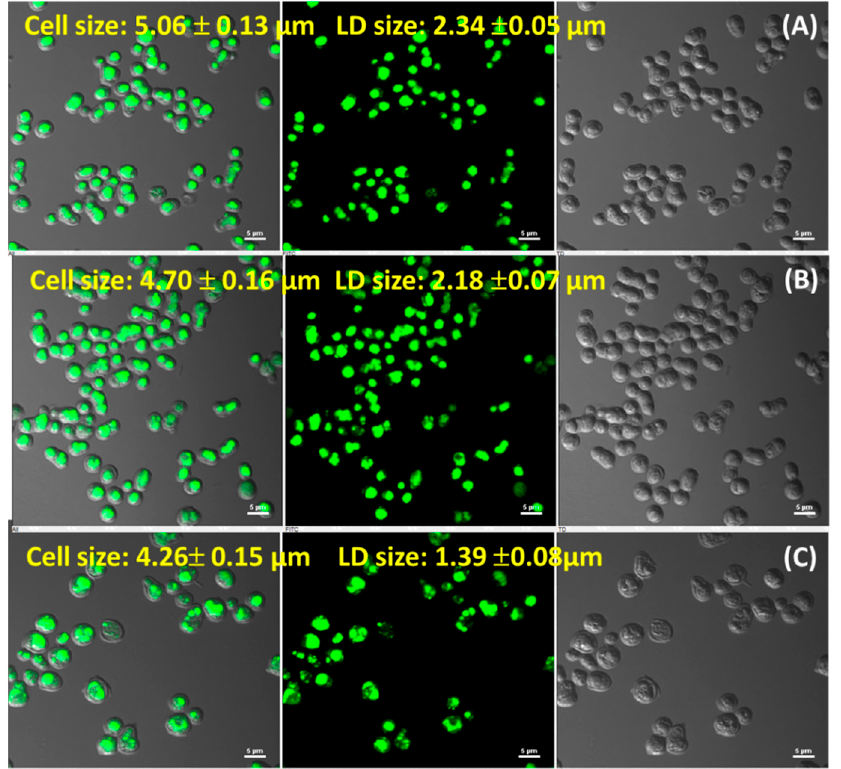
Figure 3. Confocal microscopy imaging for visualization of cell size and lipid droplet size in R. toruloides at stationary phase under different medium conditions ( A ) N-limited: 5% glucose, 0.12% (NH 4 ) 2 SO 4 (192 h), ( B ) N-sufficient: 5% glucose, 0.5% (NH 4 ) 2 SO 4 (192 h), ( C ) control: 3% glucose, 0.5% (NH 4 ) 2 SO 4 (144 h). The green fluorescence signal refers to lipid storage vesicles in the cytoplasm of R. toruloides .